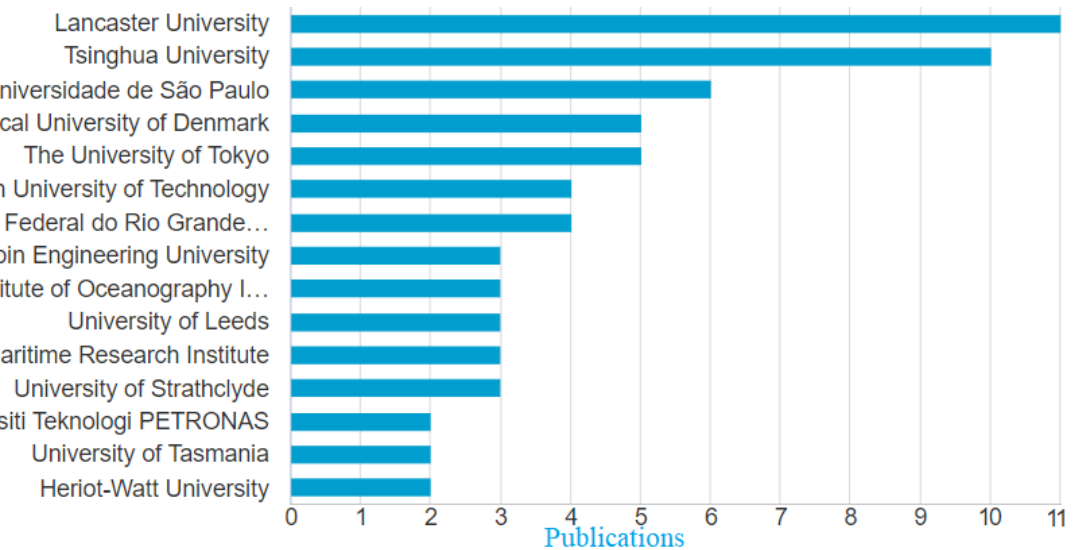
Figure 10. The affiliations by academic institutions for the research on “marine hose” (data retrieved from Scopus database, 24 July 2022).